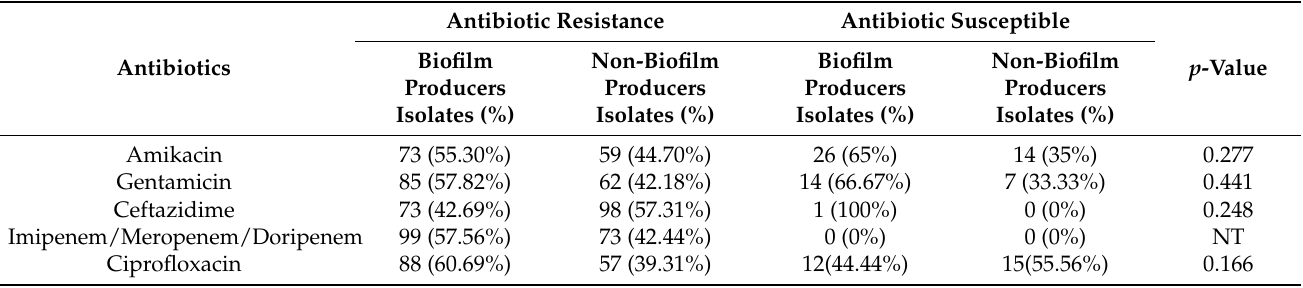
Table 2. Distribution of biofilm formation of the isolates with different antibiotic resistance pheno- types among A. baumannii